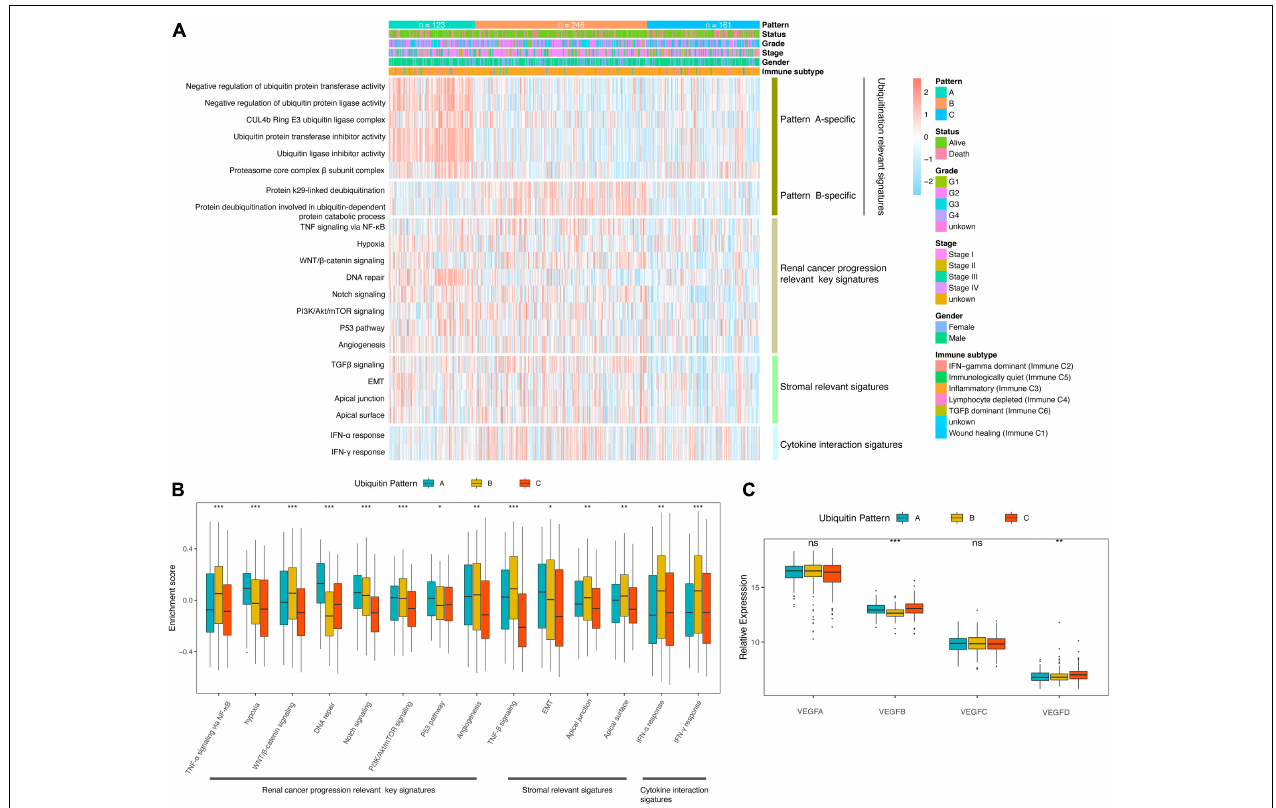
FIGURE 2 | Molecular characteristics of the ubiquitin pattern. (A) Heatmap of the ubiquitin-relevant signature of the subclasses. (B) Boxplot of the GSVA enrichment score of ccRCC progression-relevant signatures. (C) Relative expression of VEGF family distinguished by ubiquitin patterns. The median values of the enrichment scores were compared using the Kruskal–Wallis test. Statistical significance levels were indicated with asterisks above the boxplot (ns, no statistical difference, * p < 0.05, ** p < 0.01, *** p <